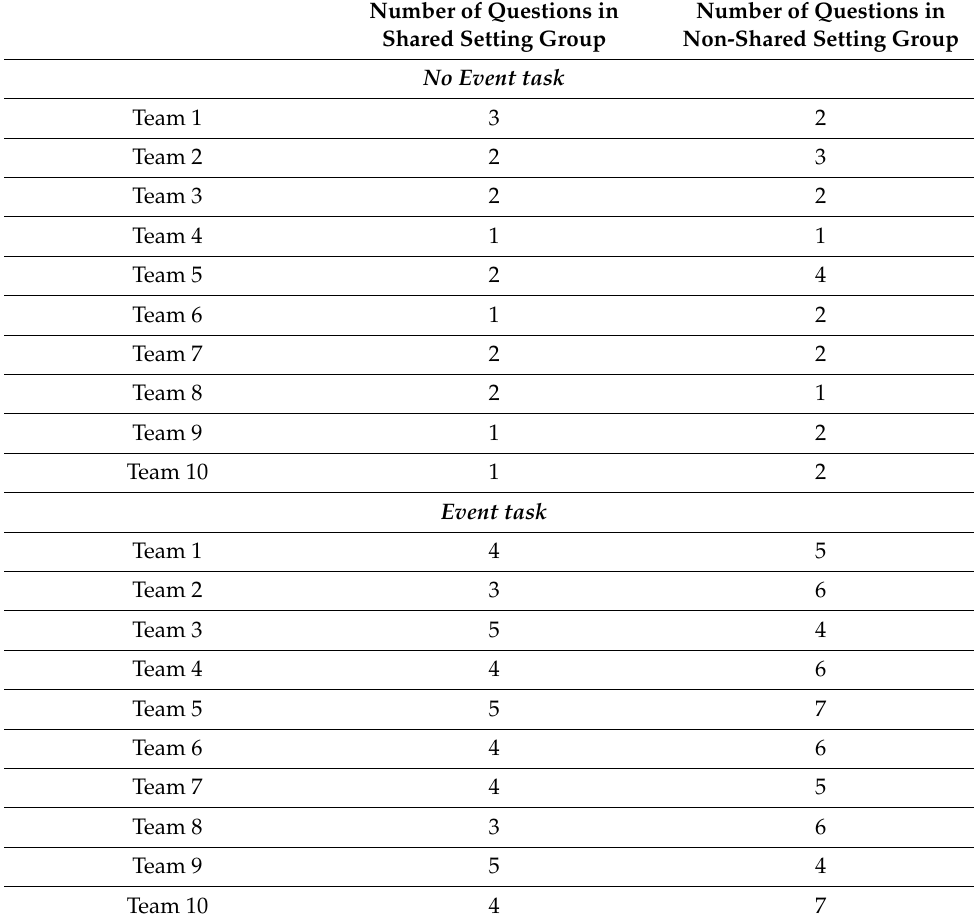
Table 3. The number of questions among the team members (NQ) about the status of the mission. Number of Questions in Shared Setting